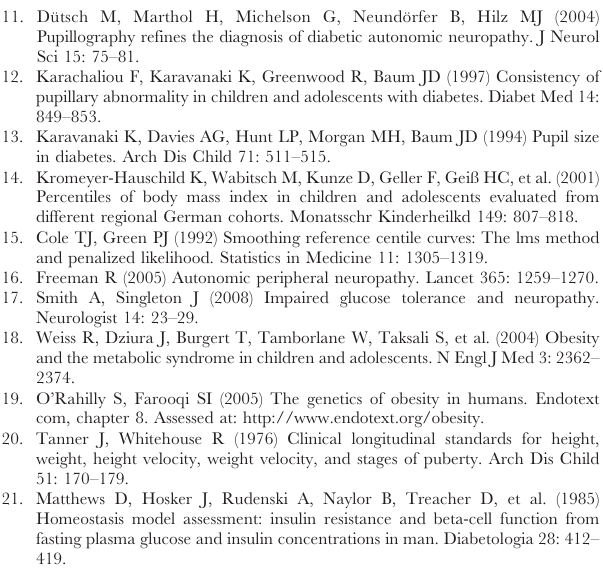
Table S1 Group comparison of additional autonomic nervous function measurements. Values are given as mean 6 SD (first line) and min-max (second line). Group comparisons were performed by a two-sample